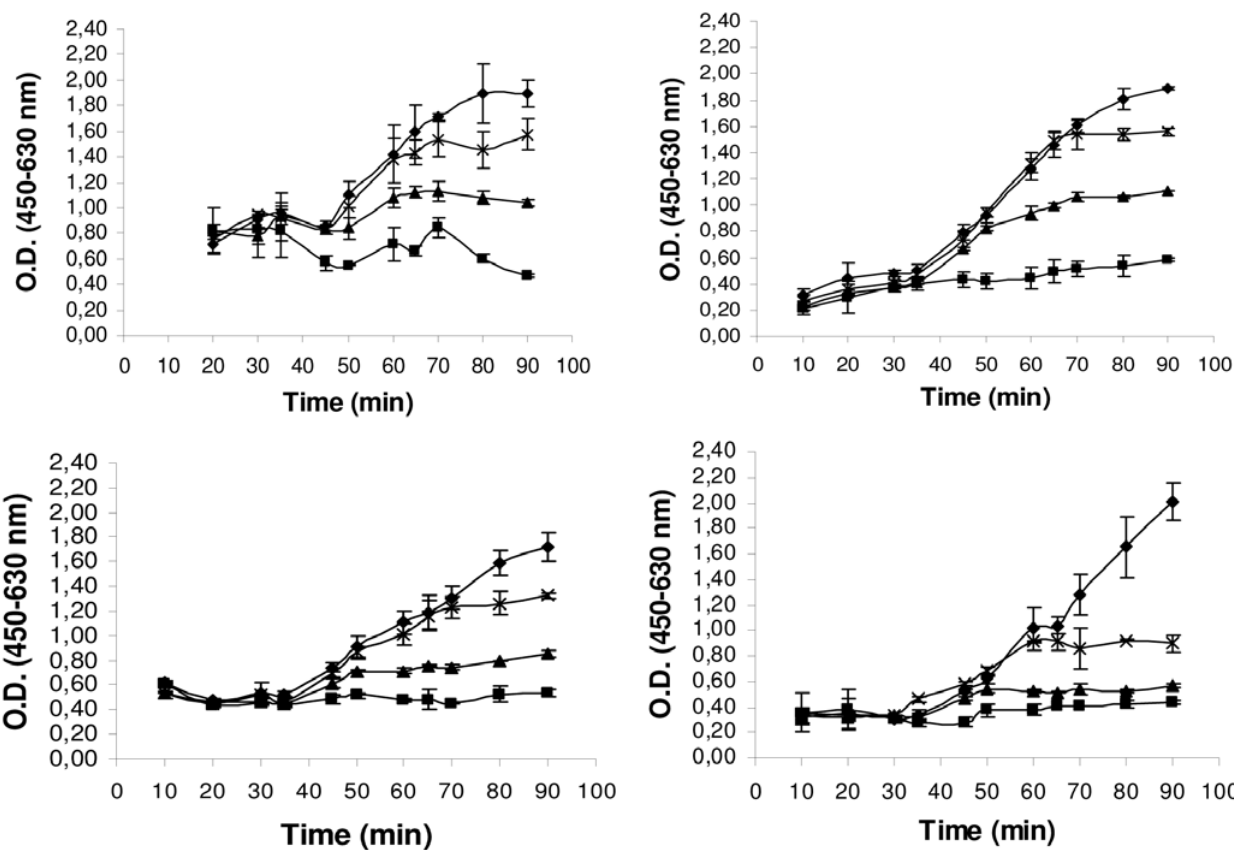
Table 5. Host specificity of anticomplement activity by recombinant IxACs from I. ricinus . .. ... .... ... ... .... ... ... .... ... ... .... ... ... .... ... ... .... ... ... .... ... ... .... ... ... .... ... ... .... ... ... .... ... ... .... ... ... .... ... ... .... ... ... . Serum source AH50 Irac I Irac II IxAC-B1 IxAC-B2 IxAC-B3 IxAC-B4